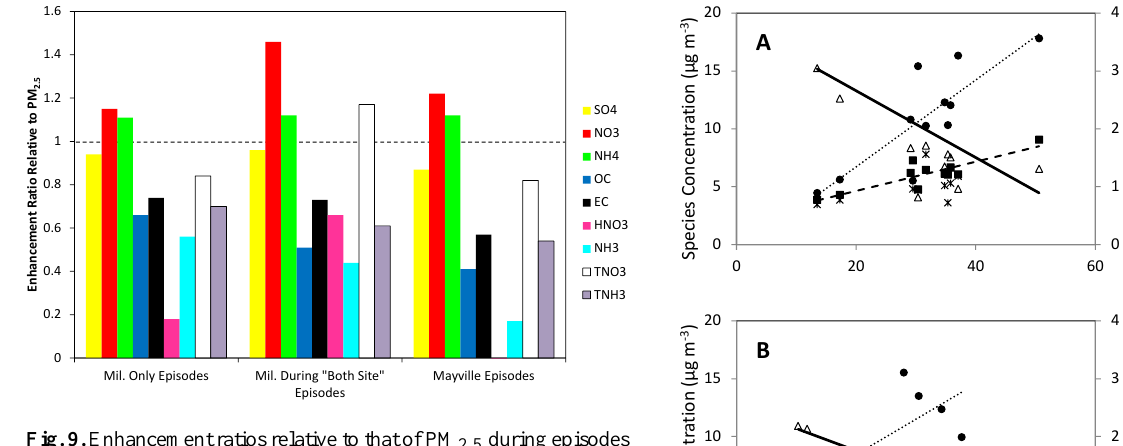
Figure 9. Enhancement ratios relative to that of PM 2.5 during episodes of various species 1009 Fig. 9. Enhancement ratios relative to that of PM 2 . 5 during episodes of various species.